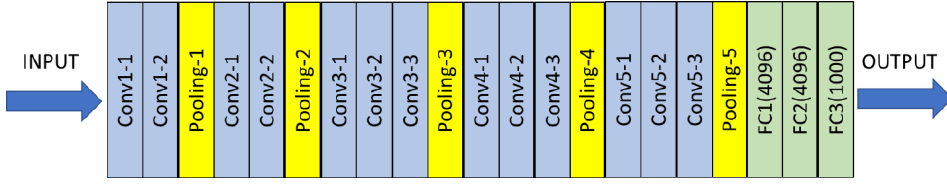
Figure 3. VGG-16 architecture. Conv means convolutional layer; and FC means fully-connected layer. VGG-16 has been widely used for classification tasks by means of transfer learn- ing [21,22]. One of the transfer-learning alternatives is to freeze the filter weights up to a specific layer in the network discarding the other layers, and then adding new fully connected layers to the frozen network. Therefore, the trainable parameters are only those corresponding to the FC layers (since the others are transferred from the pre-trained model). In this case, the last pooling layer (i.e., pooling_5) was selected to transfer the pre- trained weights to the new model. Like the original network, three FC layers were added, but with a lower number of outputs because the total classes of the current problem are significantly smaller than those of the original problem. Specifically, the three FC layers have 512, 200 and 2 units, respectively. Before the last FC layer, we add a dropout of 0.25. The last layer does not have one unit (unlike typical binary classification problems) but